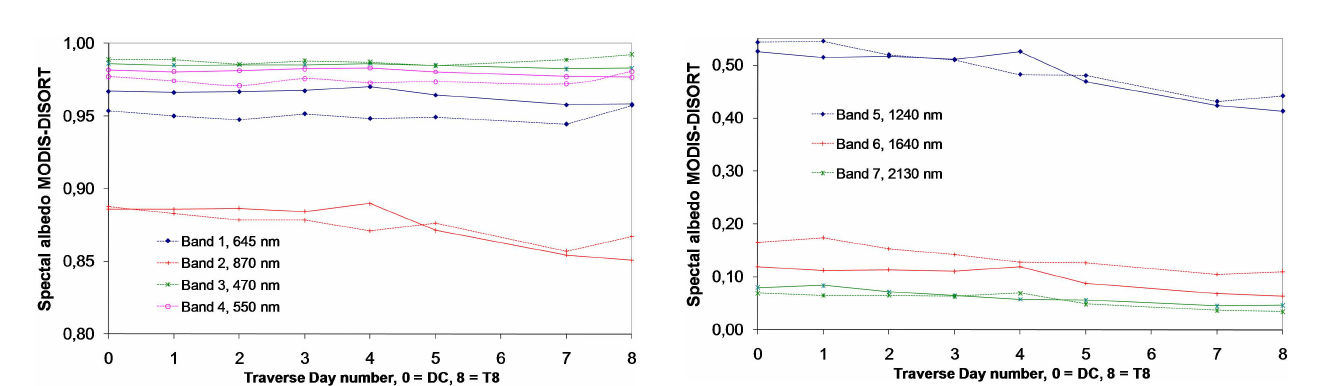
Fig. 17. Spatial variations of the spectral albedo during the traverse. Data shown compare values obtained for MODIS bands 5 to 7, with those calculated for the same wavelengths using DISORT and our snow SSA and density profiles (solid